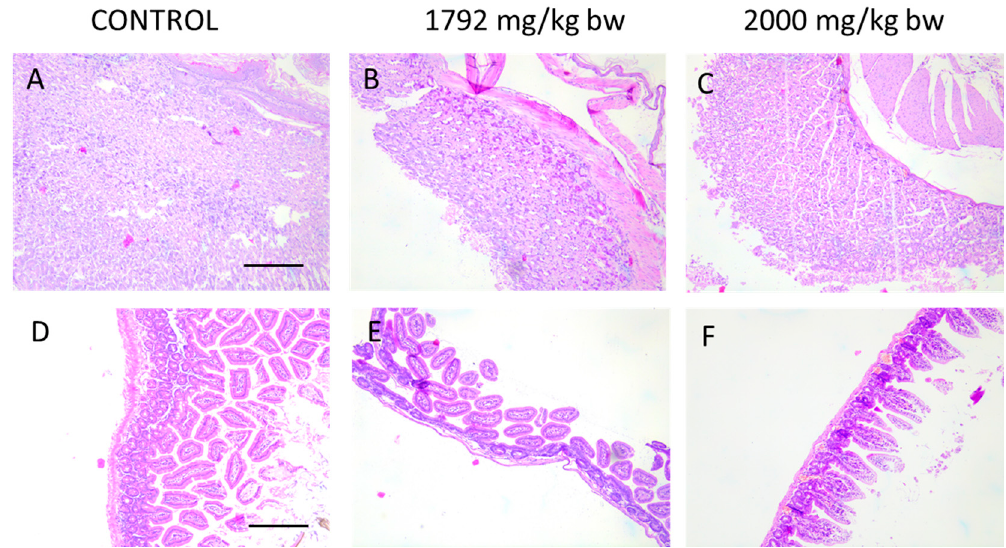
Figure 5. Histological images of stomach ( A – C ) and intestine ( D – F ) showing no pathological changes in animal receiving the highest doses of HA extract in acute toxicity study. Magnification 100×.